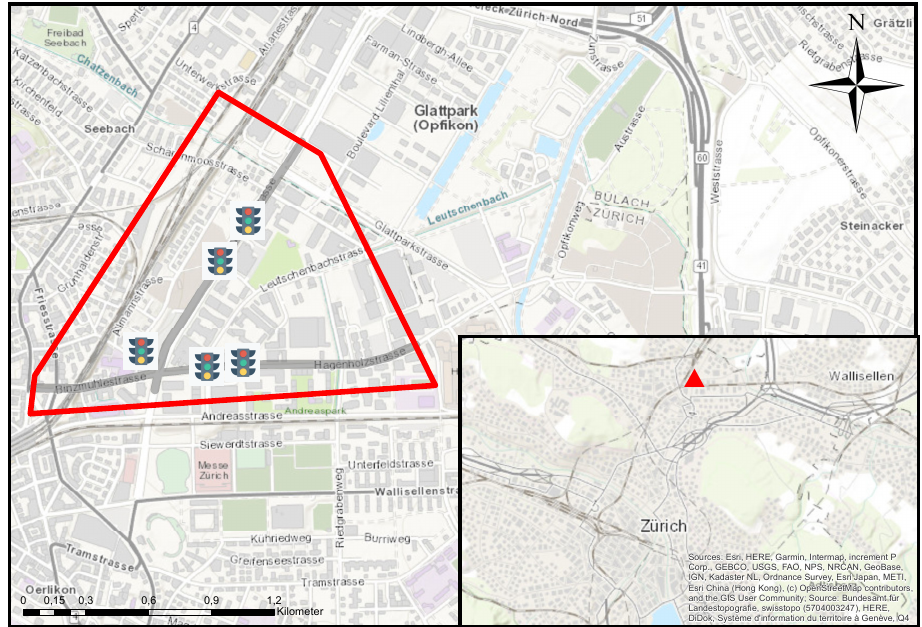
Figure 2. Test area (in red), Zurich Switzerland. The highlighted network in gray indicates the road segments where data is collected and processed. The traffic light symbols indicate the five implemented traffic control